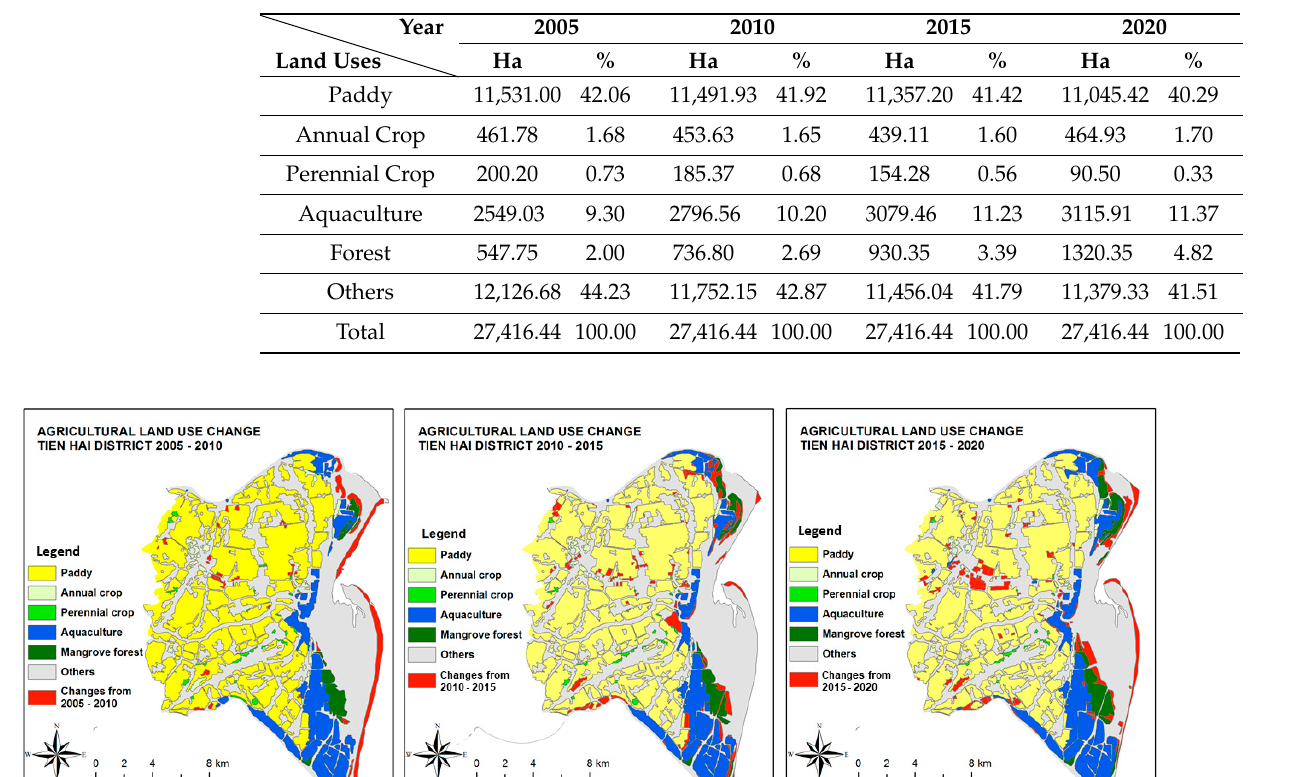
Table 4. Areas of different land-use types in Tien Hai district over time.